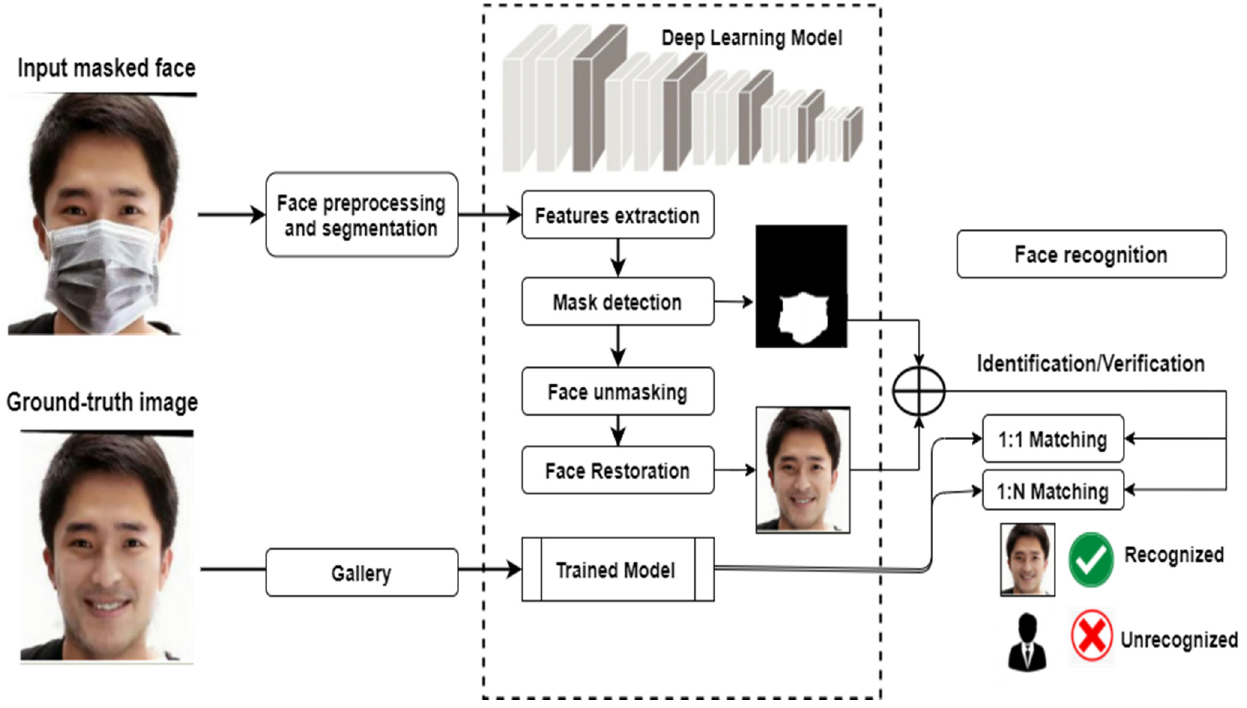
Figure 2. A pictorial representation of the masked face recognition framework.